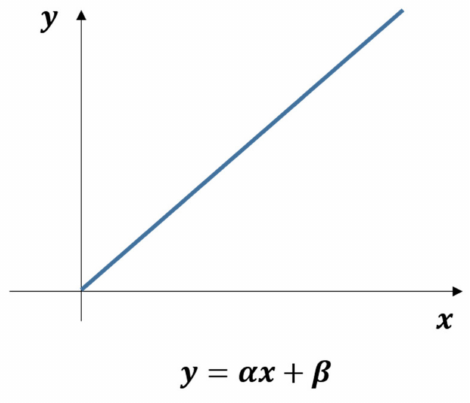
Figure 6. Linear regression analysis